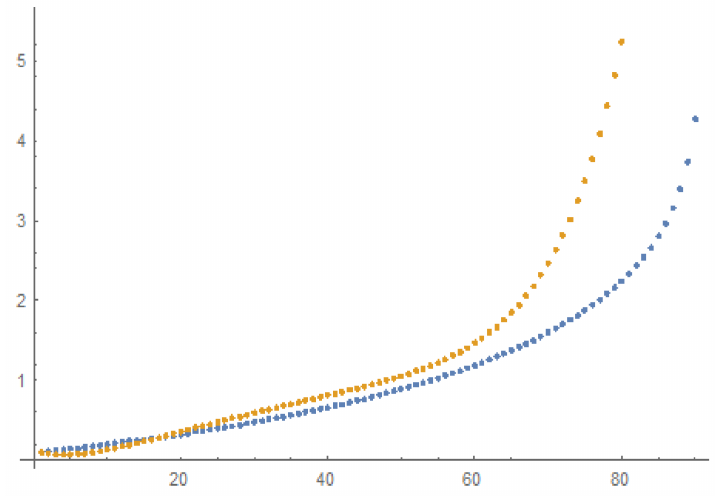
Figure 4. The real data (blue line) and the approximate trajectory (orange line).